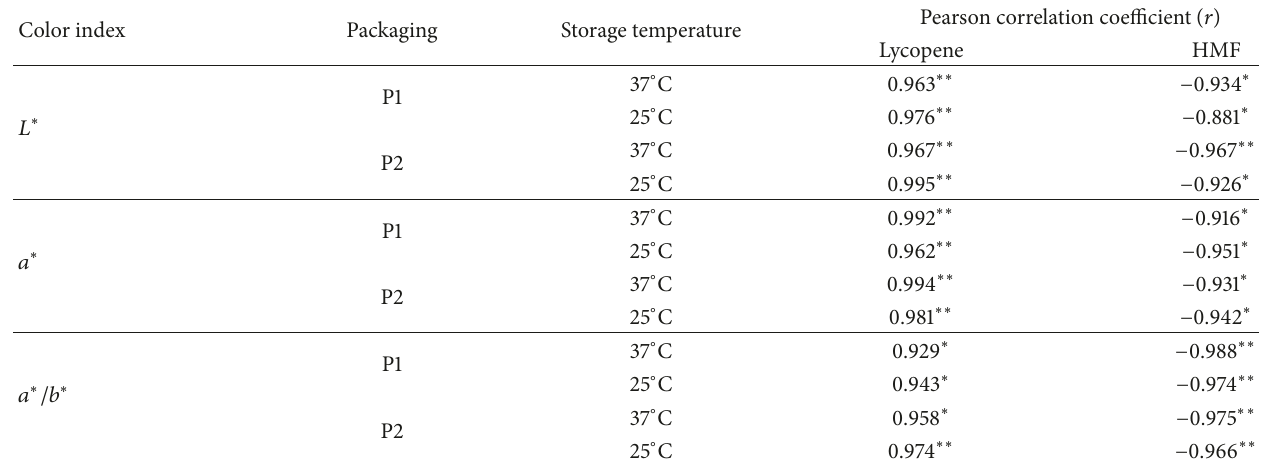
Table 3: Correlation analysis of 𝐿 ∗ , 𝑎 ∗ , 𝑎 ∗ /𝑏 ∗ with lycopene and HMF in THPS during storage. Color